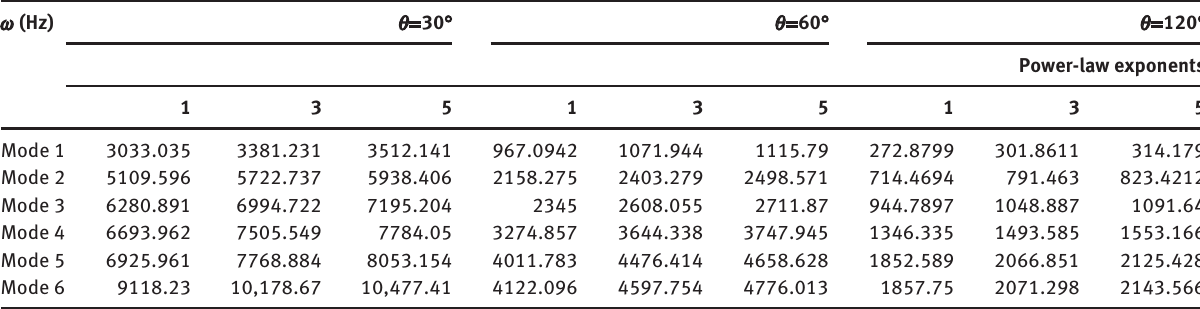
Table 3 Natural frequencies of an isotropic FG annular sector plate clamped at the radial edges for different power-law exponents and sector